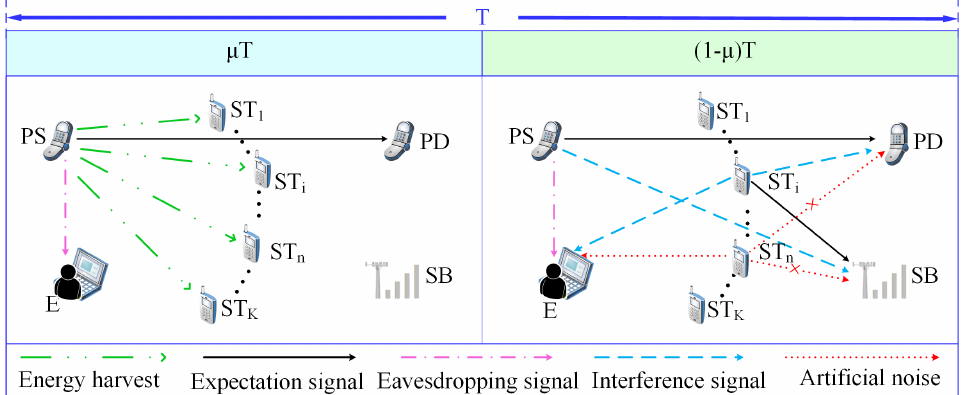
Figure 2. An energy-harvesting cognitive underlay system model. ( µ T : the segment slot for energy harvest and only primary signal transmission. ( 1 − µ ) T : the segment slot for primary and secondary signals